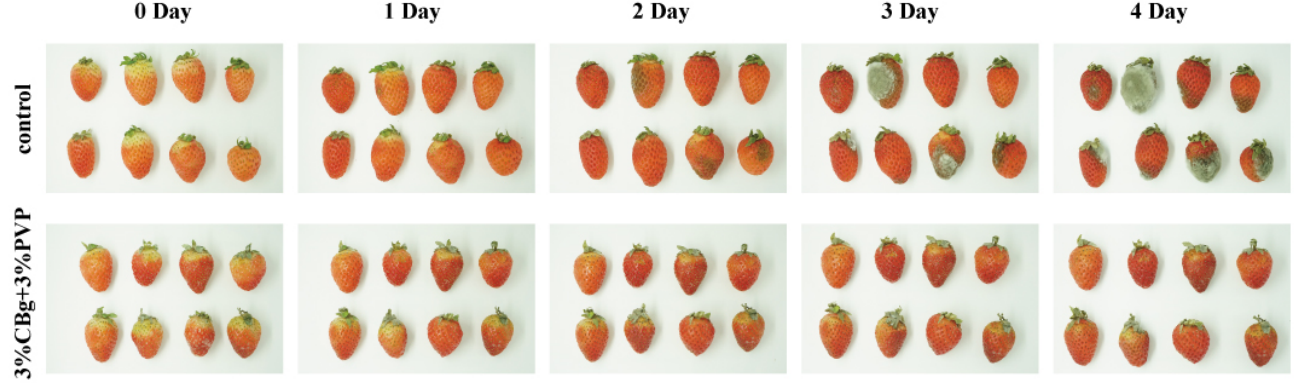
Figure 6. Photographic images of strawberries coated/uncoated with 3CB/PVP films.